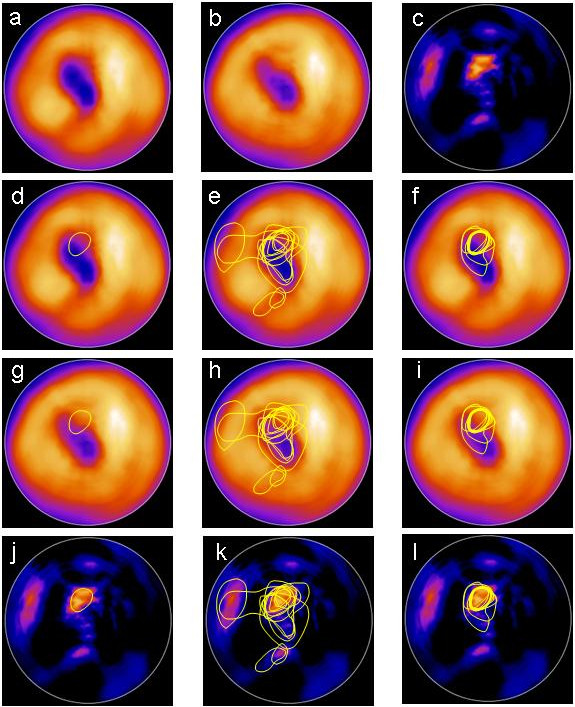
The delineations of the ischemic area made by the physicians and by EXINI for one of the patients. The upper row shows the stress (a) and rest (b) polar plots as well as the difference rest-stress plot (c). The second row shows the delineation made by EXINI (d), the delineations made by the 11 physicians without (e) and with (f) suggestion of the delineation provided by EXINI for stress polar plots. The third and forth rows show the same delineations for rest polar plots (g, h, i) and difference rest-stress plots (j, k, l). The physicians were able to choose between stress, rest or difference polar plots for their delineations.